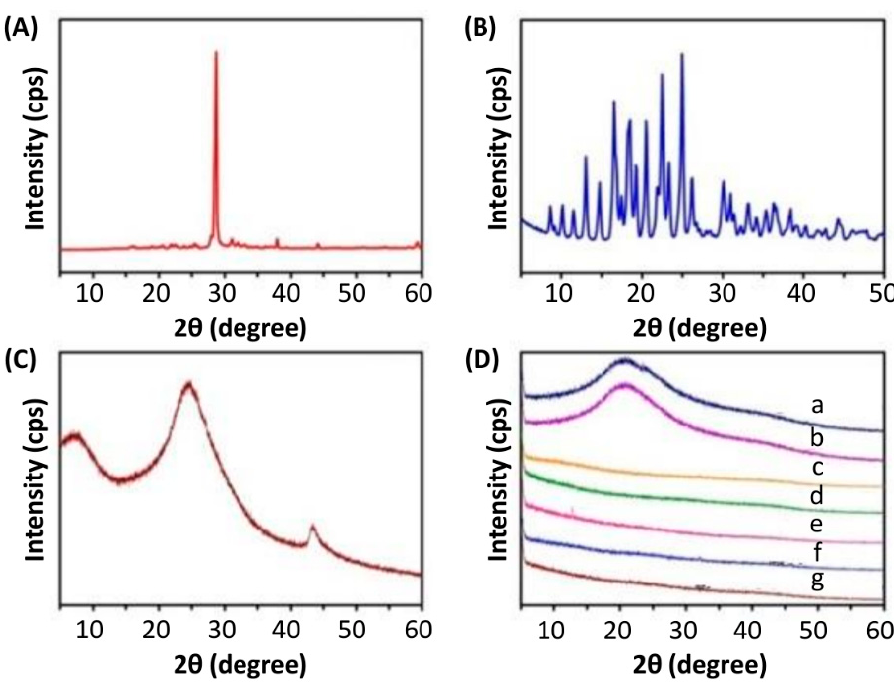
Figure 2. XRD spectra of ( A ) 5-FU, ( B ) DOX, ( C ) rGO and ( D ) different beads: (a) GL beads; (b) GL-DOX; (c) SA beads; (d) SA-5-FU; (e) SA-5-FU-GL-DOX; (f) SA-rGO-5-FU; and (g) SA-5-FU-rGO-GL-DOX.